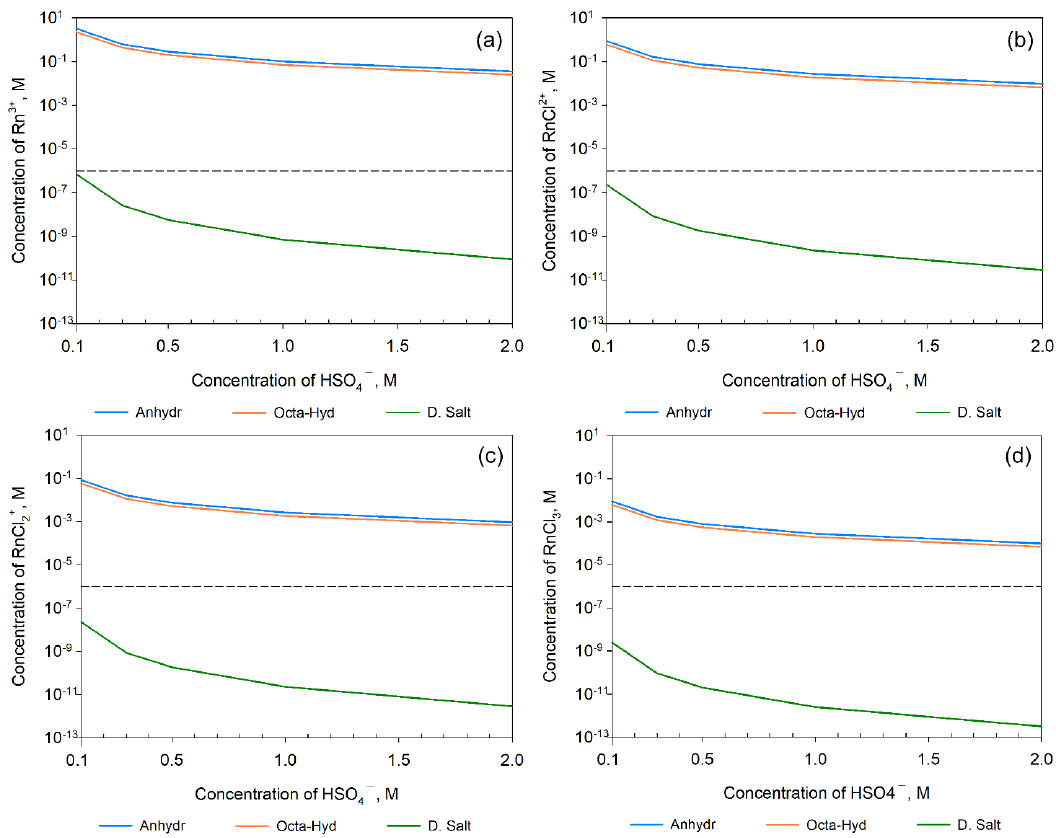
Figure 4. Graphical presentation of precipitation of Rn 3+ , RnCl 2+ , RnCl 2+ , and RnCl 3 into three sulfates, anhydrous, octa- hydrated, and sodium double salt at pH 1 with HCl (dashed line: 1 ppm line). ( a ) Rn 3+ precipitates into the three products. ( b ) RnCl 2+ precipitates into the three products. ( c ) RnCl 2+ precipitates into the three products. ( d ) RnCl 3 precipitates into the three products.